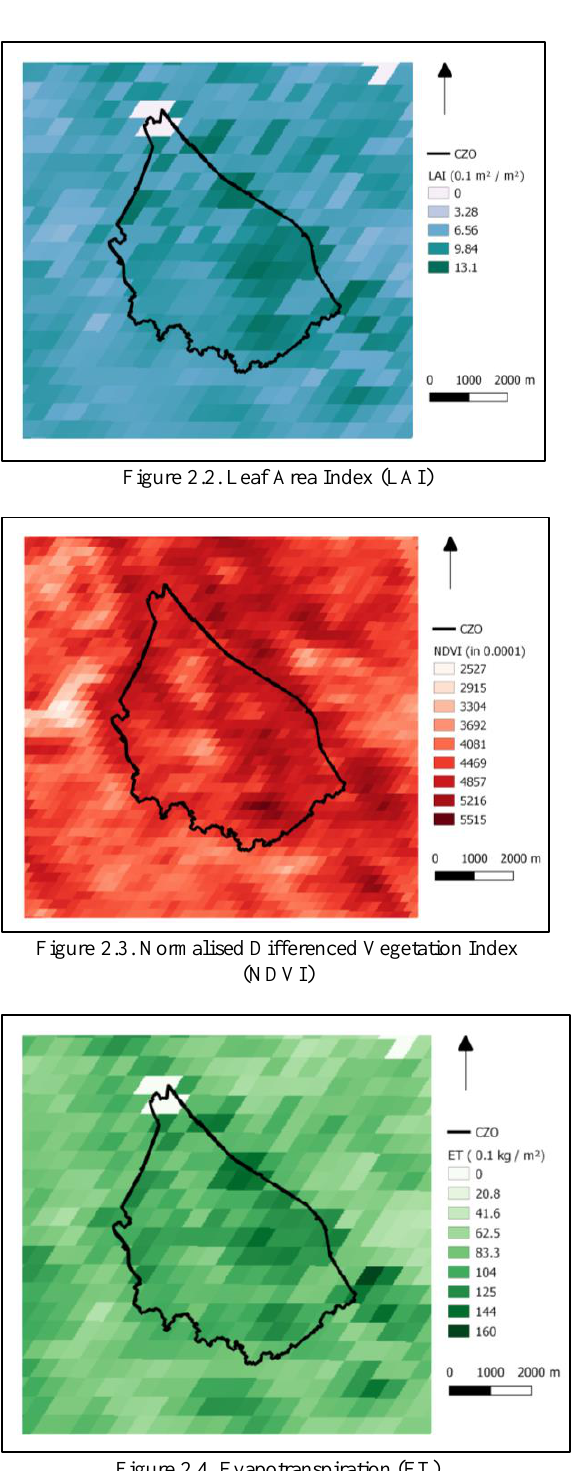
Figure 2.4. Evapotranspiration